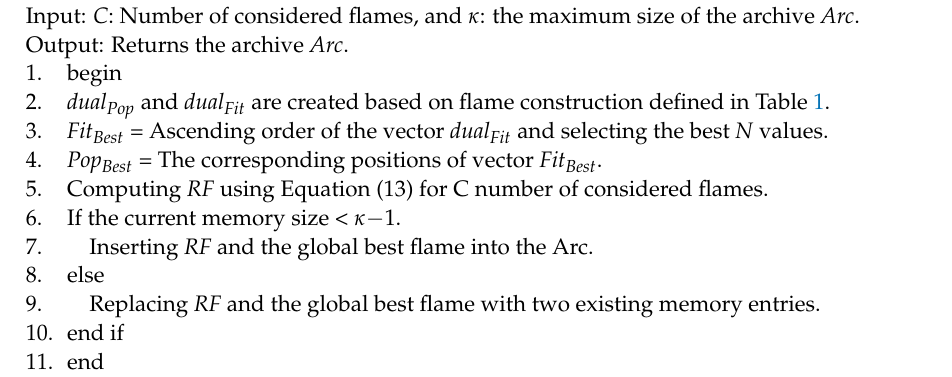
Algorithm 1. The pseudocode of the archive construction